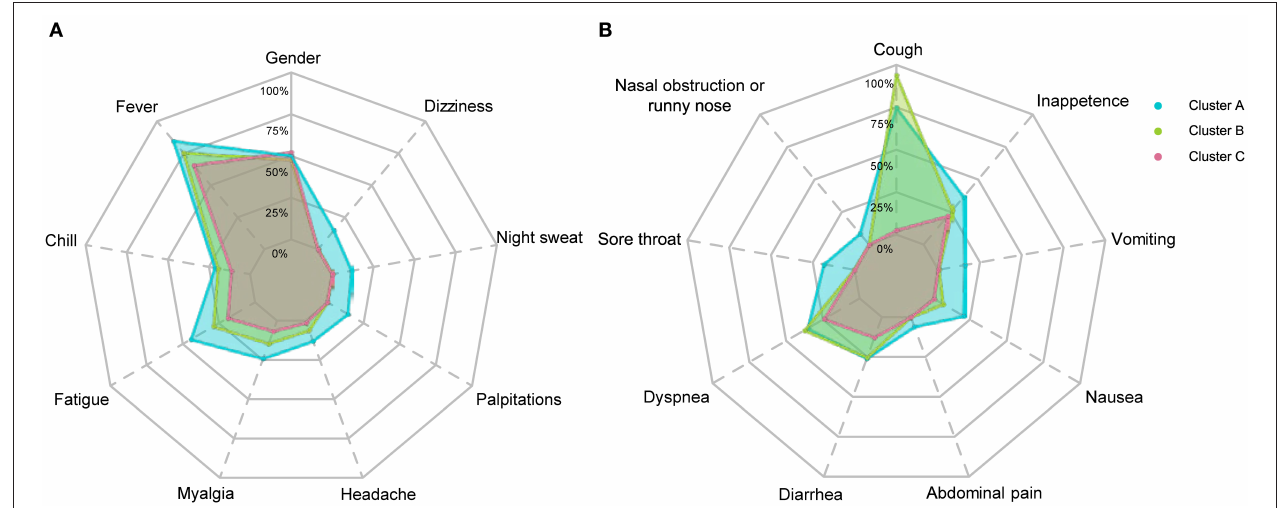
FIGURE 5 | Frequencies of symptoms of COVID-19 patients in three clusters. Frequencies of systematic symptoms and nervous system symptoms are shown in (A) and frequencies of respiratory symptoms and digestive tract symptoms are shown in (B) . Symptoms labeled with dashed lines have significant differences ( p < 0.05) among the three clusters. The χ 2 test or Fisher’s exact test were